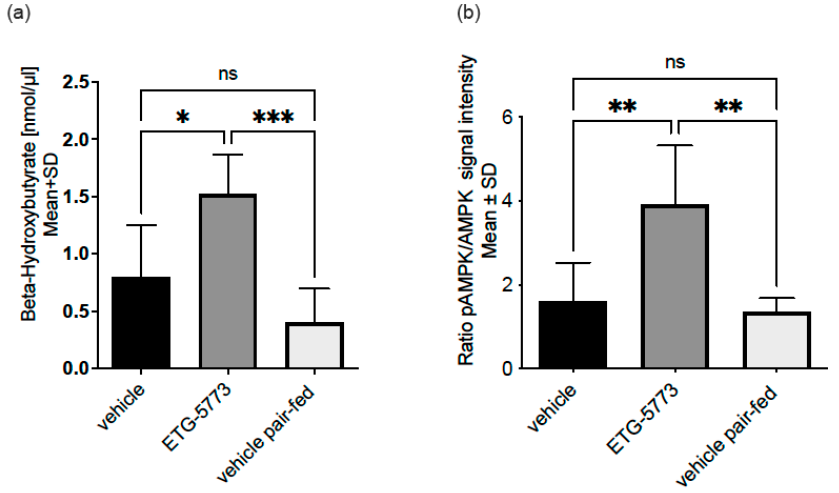
Figure 7. Energy metabolism biomarkers in the DIO mouse model treated with ETG-5773 for 7 days. ( a ) β -hydroxybutyrate ( β -HBA) levels measured in an ELISA; ( b ) adenosine monophosphate-activated protein kinase (AMPK) activation levels measured in a Western blot and normalised for actin. Animals were treated orally twice a day with 15 mg/kg ETG-5773 or with the corresponding vehicle or vehicle in the pair-fed group. * p < 0.05, ** p < 0.01, *** p < 0.001 as indicated ns: non-significant. ANOVA mean SD, n = 6. Corresponding western blot data are shown in Figure S5.